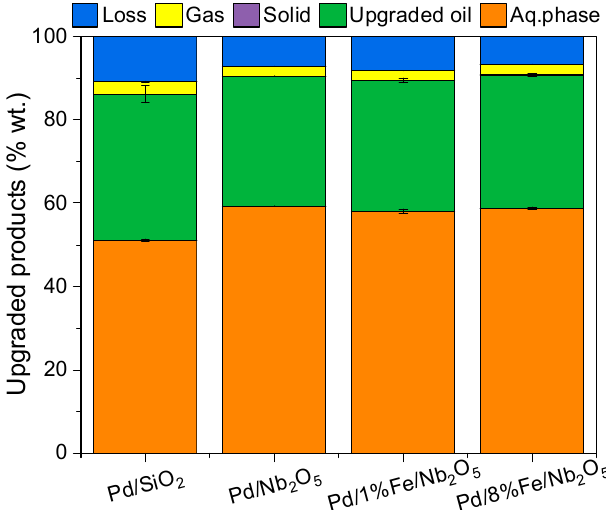
Figure 5. HDO products and losses observed for the different catalyst tests.